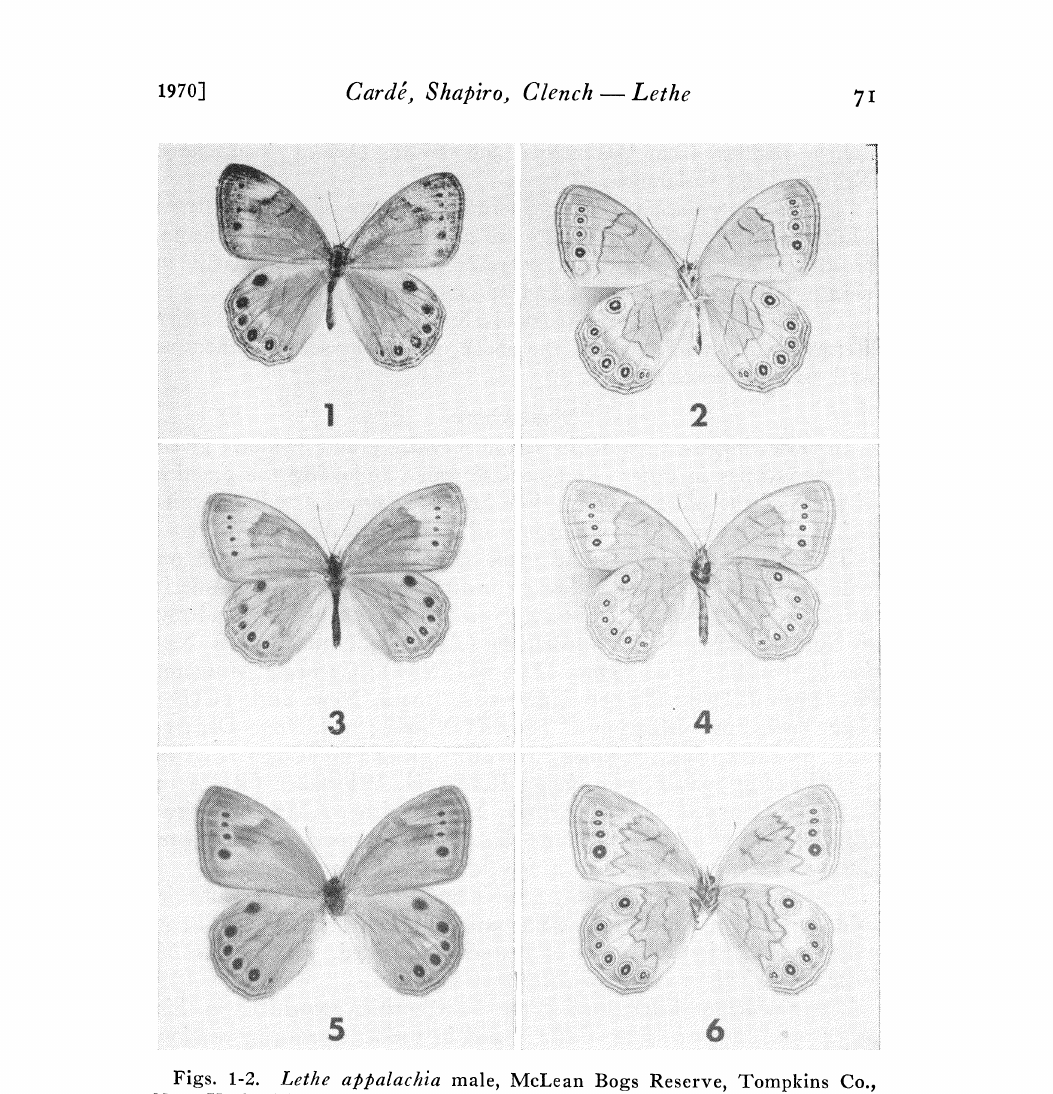
Figs. 1-2. Lethe alalachia male, McLean Bogs Reserve, Tompkins Co., New York. Figs. 3-4. Lethe eurydice (male) neotype, Morris Arboretum, Philadelphia Co., Pennsylvania. Figs. 5-6. Lethe eurydice fumosa male, Sarpy Co.,